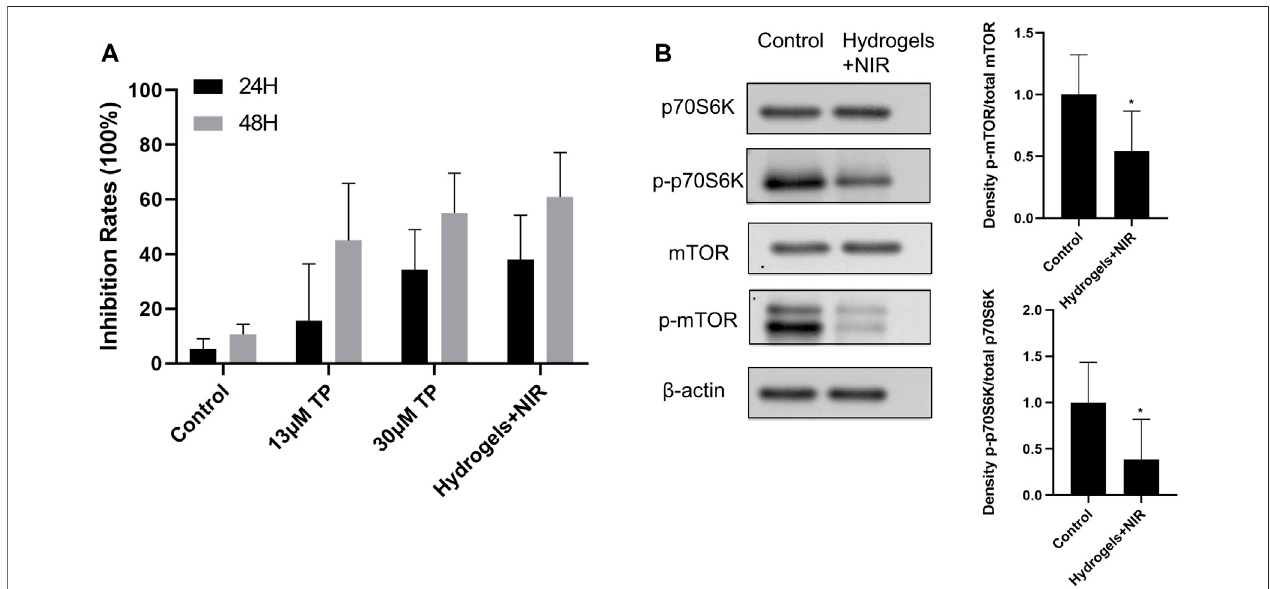
FIGURE 6 | (A) Anti-proliferative effect of TP-PLGA-Au@RGD/HA hydrogels on RA-FLS. The data were obtained from three independent experiments and are expressedasmean±SD. (B) TP-PLGA-Au@RGD/HAhydrogelsreducedlevelsofphospho-mTOR(p-mTOR),withap-mTOR/totalmedianreductionof54%,andlevels ofphosphorylation ofmTORtargetswithaphospho-p70S6K(p-p70S6K/totalmedianreduction of38%,indicatinginhibition ofthemTOR pathway. Dataareexpressed as mean ± SEM values. *P < 0.05 compared with the blank group.